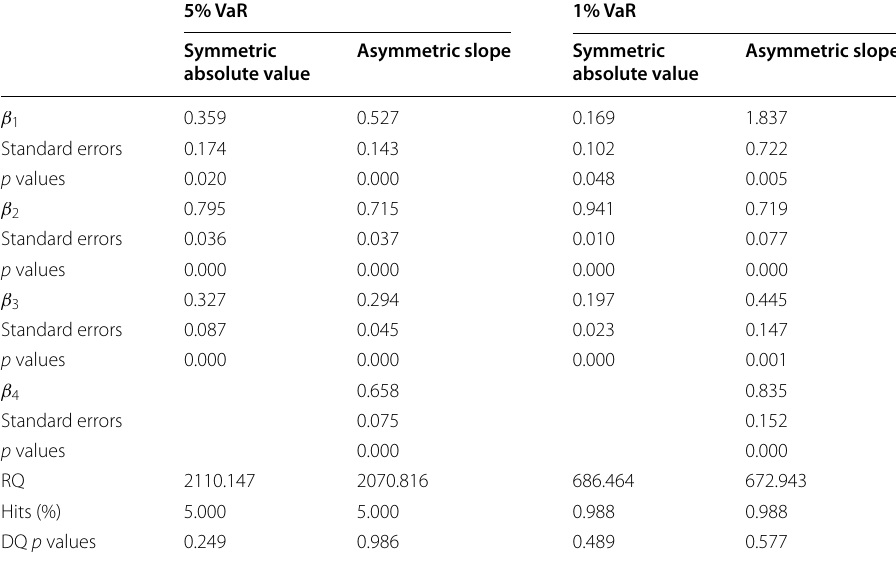
Table 3 Estimates and relevant statistics for the 5% and 1% CAViaRs of Bitcoin’s